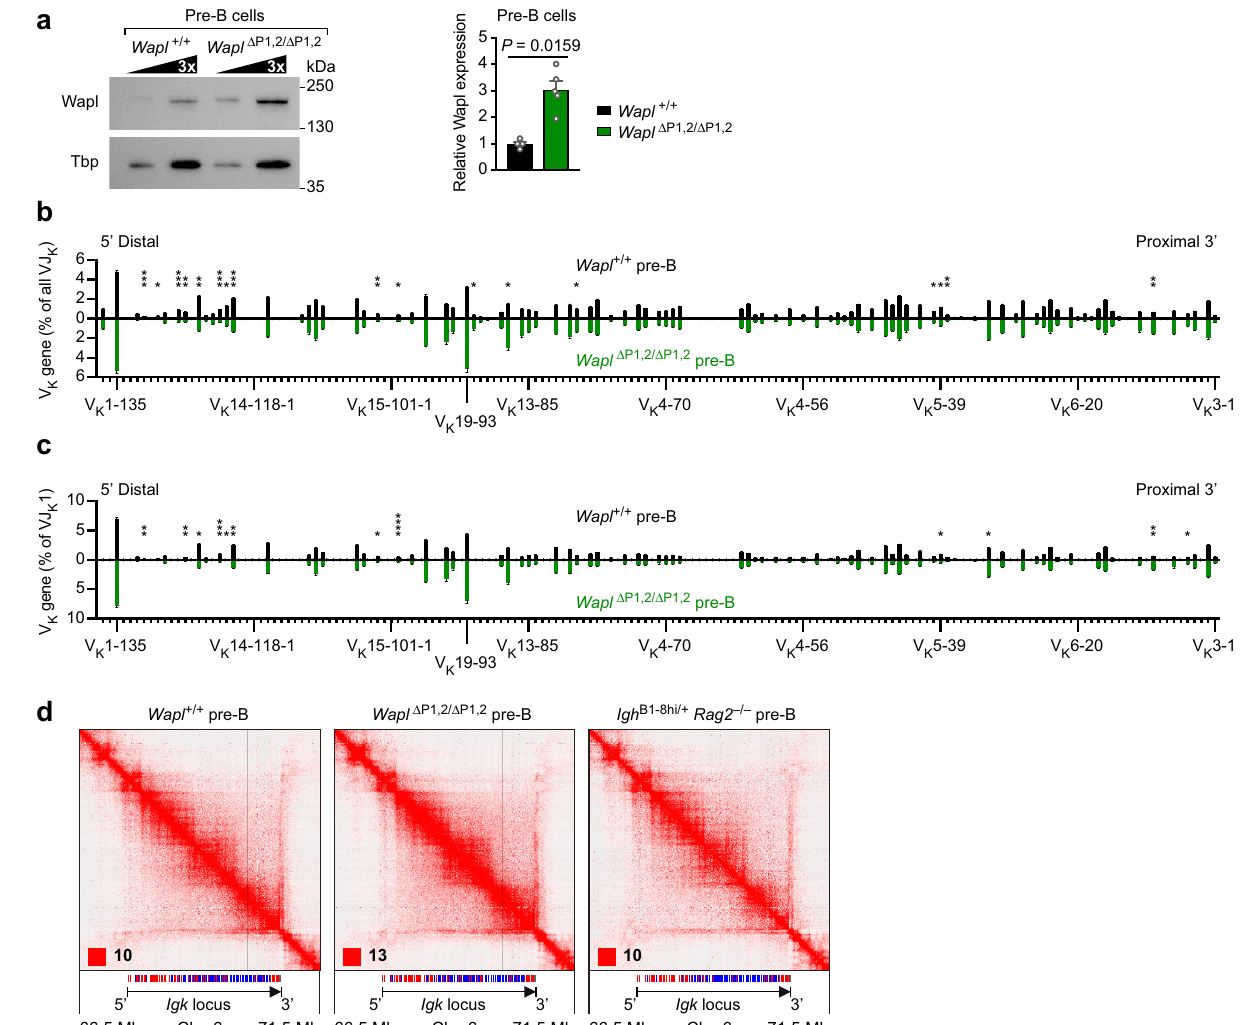
Fig. 1 | Ef fi cient V K -J K rearrangements and long-range interactions across the Igk locus upon high Wapl expression in Wapl Δ P1,2/ Δ P1,2 pre-B cells. a Wapl expression in ex vivo sorted pre-B cells from the bone marrow of Wapl +/+ (black) and Wapl Δ P1,2/ Δ P1,2 (green) mice, as determined by immunoblot analysis of threefold serially diluted whole-cell extracts with antibodies detecting Wapl or the TATA- binding protein (Tbp; loading control). Marker proteins of the indicated size (in kilodaltons, kDa) are shown to the right. The quanti fi cation of four independent immunoblot experiments is indicated to the right. Statistical data are shown as mean values with SEM and were analyzed with the Student ’ s t -test (unpaired and two-tailed). b , c V K gene recombination analysis of ex vivo sorted Wapl +/+ and Wapl Δ P1,2/ Δ P1,2 pre-B cells, asdetermined by VDJ-seq experiments 37 . The VDJ-seq data obtained with Wapl +/+ (black) and Wapl Δ P1,2/ Δ P1,2 (green) pre-B cells are shown in the upperandlowerpart,respectively.TherecombinationfrequencyofeachV K geneis indicatedasapercentageofallV K -J K ( b )oronlytheV K -J K 1( c )rearrangementsandis